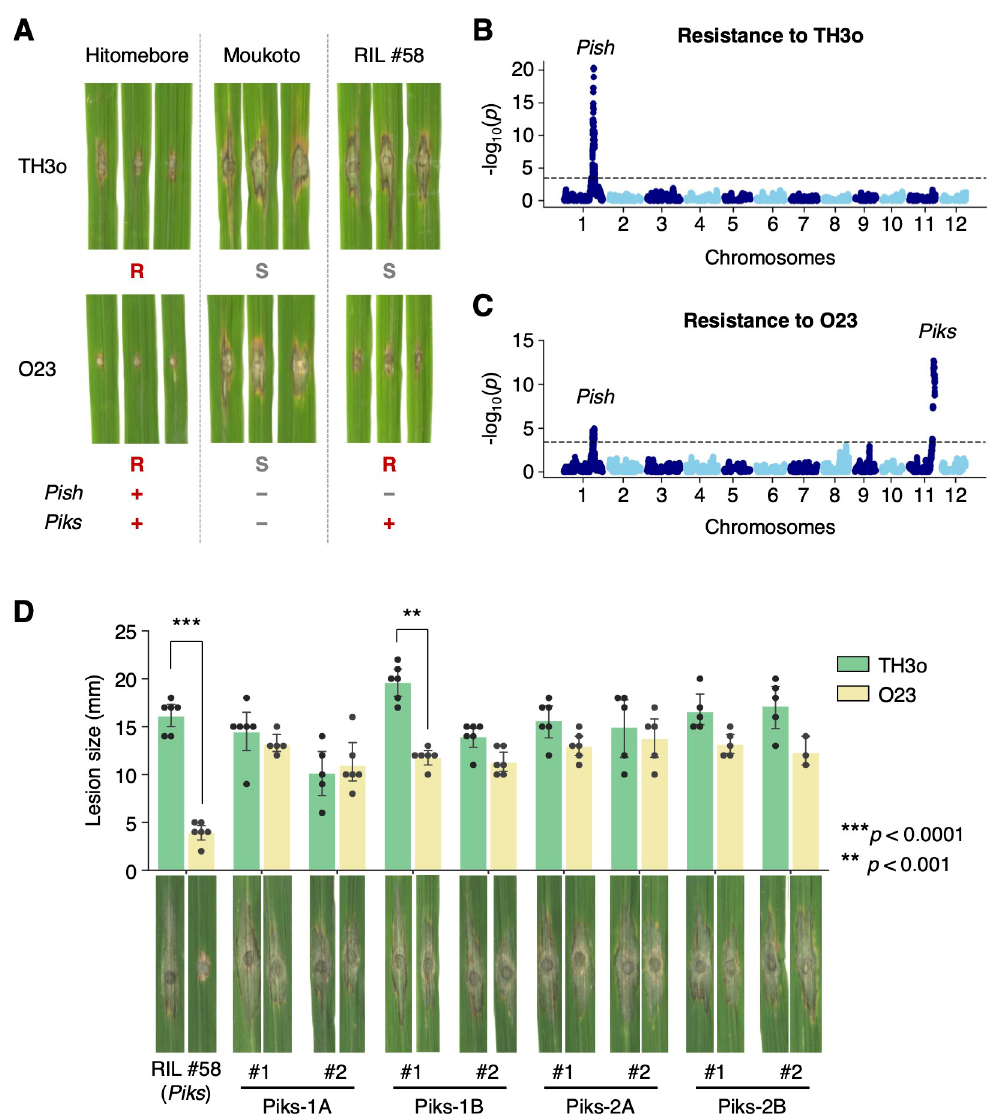
Fig 2. RILs untangle the genetics of rice cultivar Hitomebore for resistance to M . oryzae isolates TH3o and O23. (A) Punch inoculation assays using M . oryzae isolates TH3o and O23 on rice cultivars Hitomebore and Moukoto. Hitomebore is resistant ( R ) to TH3o and O23, while Moukoto is susceptible ( S ) to these isolates. RIL #58, one of the RILs produced from the cross between Hitomebore and Moukoto, is susceptible to TH3o but resistant to O23. (B) Genetic association analysis of rice RIL susceptibility to TH3o identified a locus containing the rice NLR resistance gene Pish . (C) Genetic association analysis of rice RIL susceptibility to O23 identified loci containing the rice NLR resistance genes Pish and Piks . We used 156,503 SNP markers, designed from the parental genomes, for genetic association analysis on 226 RILs. The vertical axis indicates -log 10 ( p ), where the p -value is how likely the marker shows association with a trait due to random chance. The dashed line shows the p -value corresponding to a false discovery rate of 0.05. (D) Punch inoculation assays of RNAi-mediated knockdown lines of Piks-1 and Piks-2 with the isolates TH3o and O23. We used RIL #58 ( Pish -, Piks +) as the genetic background for the RNAi lines. For each Pik gene, we prepared 2 independent RNAi constructs targeting different regions on the gene (Piks-1A and Piks-1B for Piks-1 , and Piks-2A and Piks-2B for Piks-2 , S1 Fig ). We performed punch inoculation assays using isolates TH3o and O23 with 2 RNAi lines per construct, along with RIL #58 as a control. The lesion size was quantified. Asterisks indicate statistically significant differences between TH3o and O23 (two-sided Welch’s t test). The data underlying Fig 2B – 2D can be found in S1 Data . RIL, recombinant inbred line; RNAi, RNA interference; SNP, single nucleotide